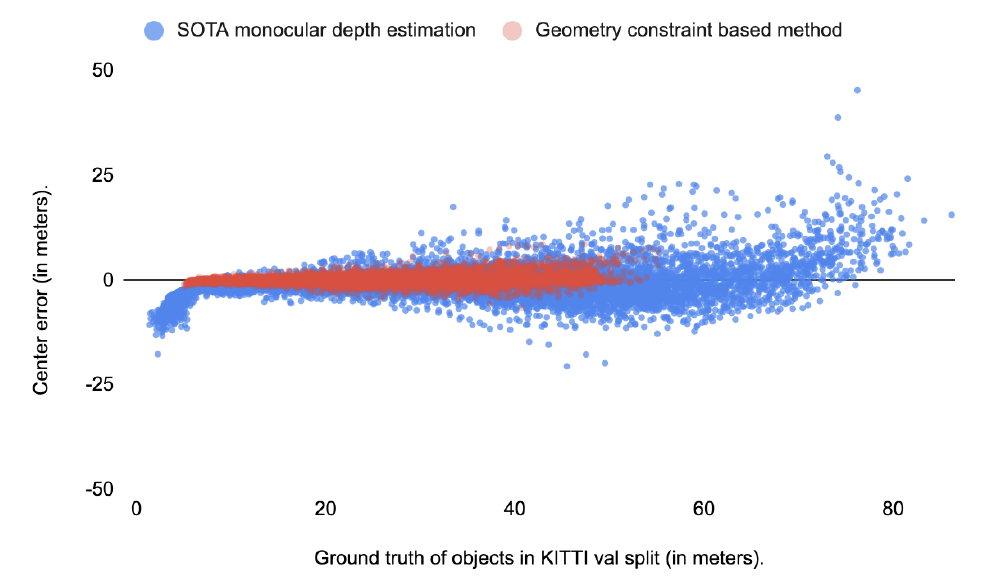
Figure 2. Comparison of monocular depth estimation errors between DORN [5] (blue data) and GUPNet [11] (red